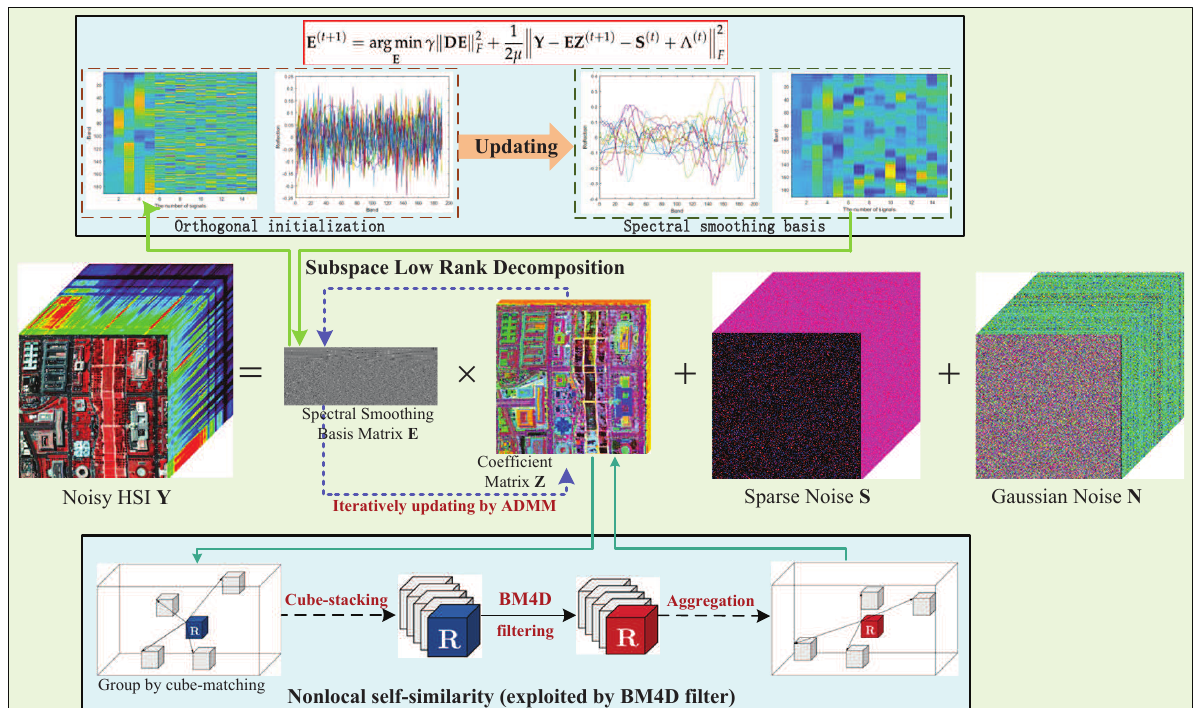
Figure 1. Flowchart of the proposed SNSSLrL